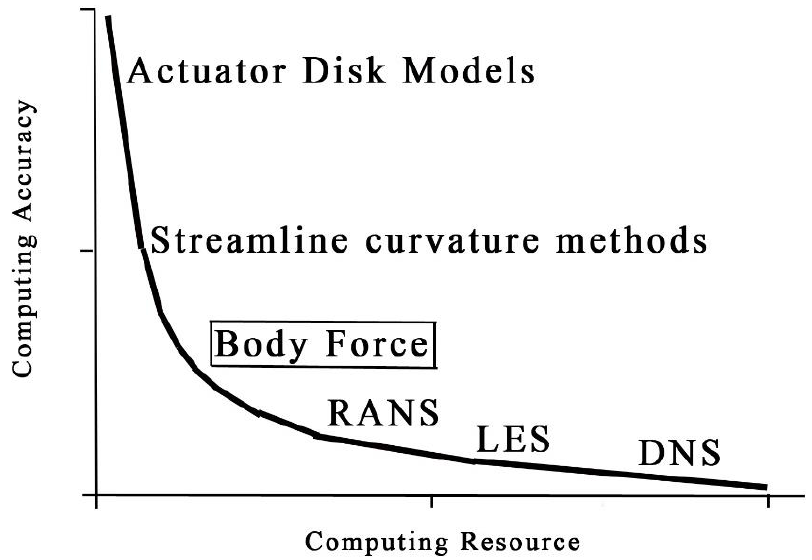
Figure 3. Demands of models on accuracy versus resources.